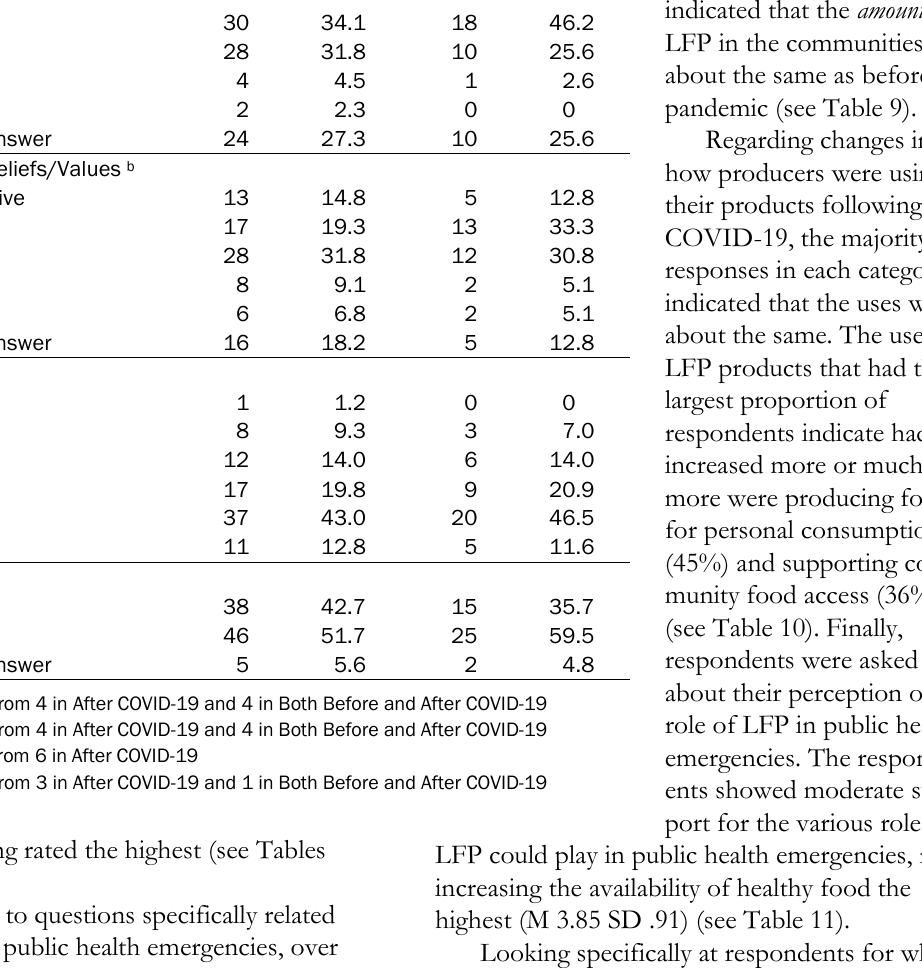
After COVID-19 ( N =92)